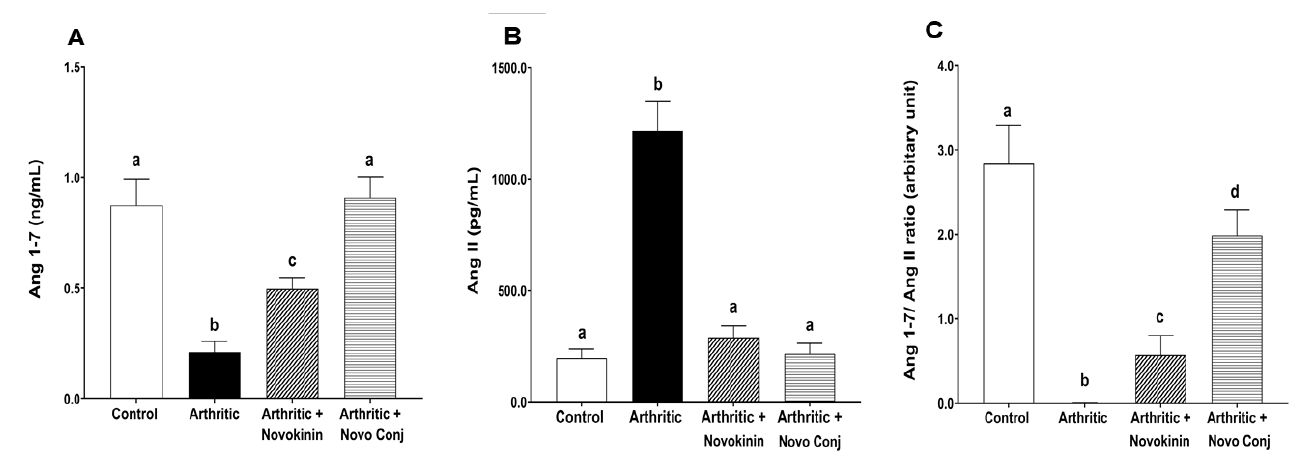
Figure 7. Novokinin and novokinin conjugate (Novo Conj) significantly increased angiotensin 1-7 (Ang 1-7) ( A ), decreased angiotensin II (Ang II) levels ( B ), and increased the Ang1-7/Ang II ratio (C) in plasma of adjuvant-induced arthritis (AIA) rats. Mean ± SD ( n =5 or 6). Triplicates samples were run. Data labeled with different letters (a, b, c, or d) indicate a statistical difference between groups where p < 0.05.